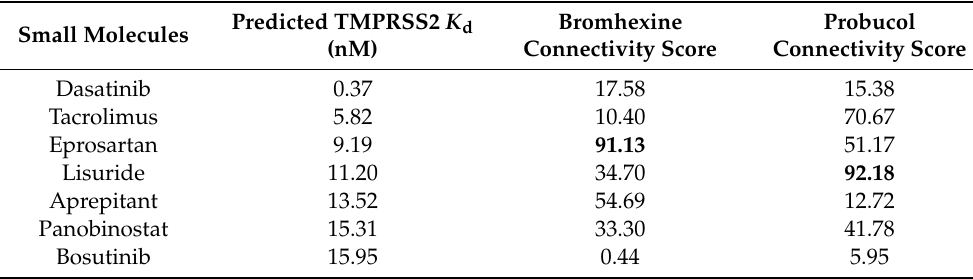
Table 4. Correlation results of seven drugs with similar gene-expression patterns to TMPRSS2 inhibitors (bromhexine and probucol) among top 30 predicted drugs with TMPRSS2 K d < 100 nM. There was no gene-expression pattern available for those drugs not listed. Bold numbers indicate connectivity score higher than 90 in the − 100–100 correlation scale. Predicted TMPRSS2 K Small Molecules